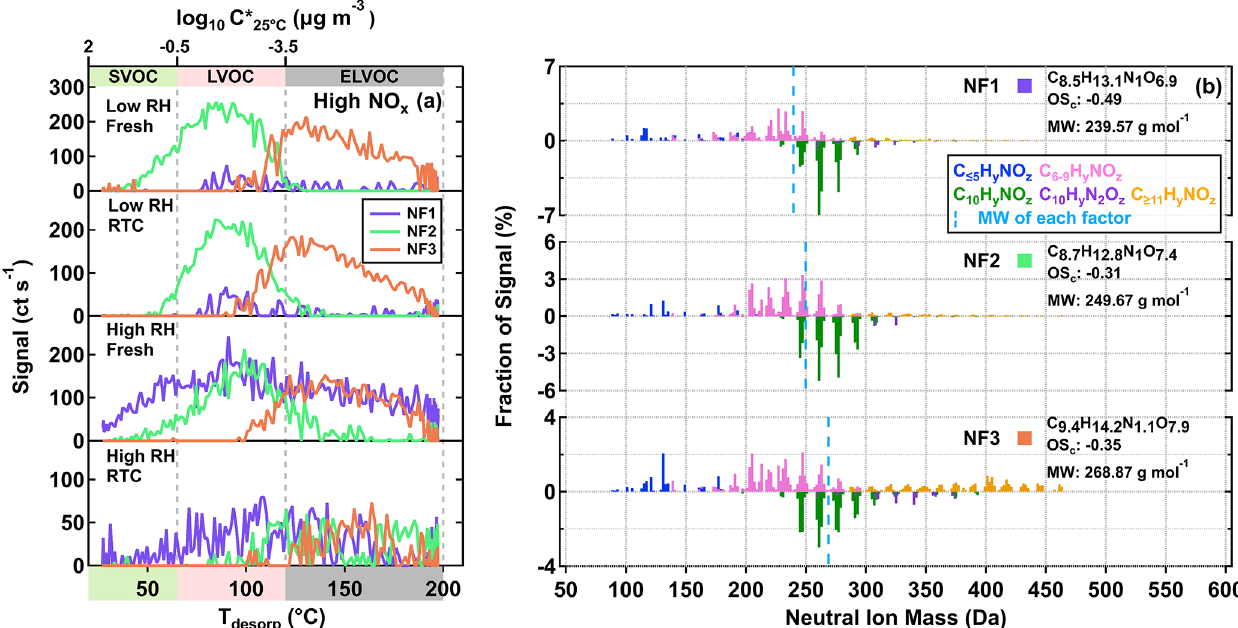
Figure 5. Factor thermograms (a) and normalized mass spectra (b) for the three sample factors from the eight-factor solution of ONs in the α -pinene SOA particles that were formed under high NO x conditions in the OFR. (a) The ranges of different volatility classes are indicated in color bands on the abscissa. In panel (b) , the bottom portion of each mass spectra represents C 10 H y N 1,2 O z . The signal-weighted molecular composition, molecular weight (MW), and oxidation state (OS c ) for each factor are shown on the right. Right next to each factor label in panel (b) , the squares are shown in the same color scheme as the factor thermograms in panel (a) to identify different sample factors. The blue dashed line indicates the average MW of each